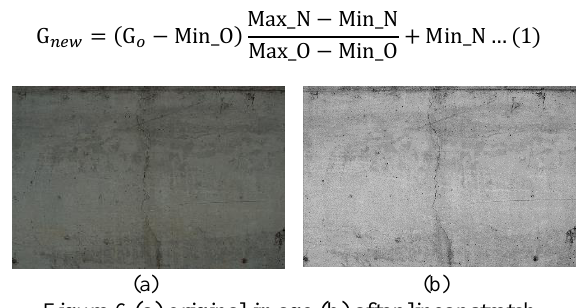
Figure 6 (a) original image (b) after linear stretch